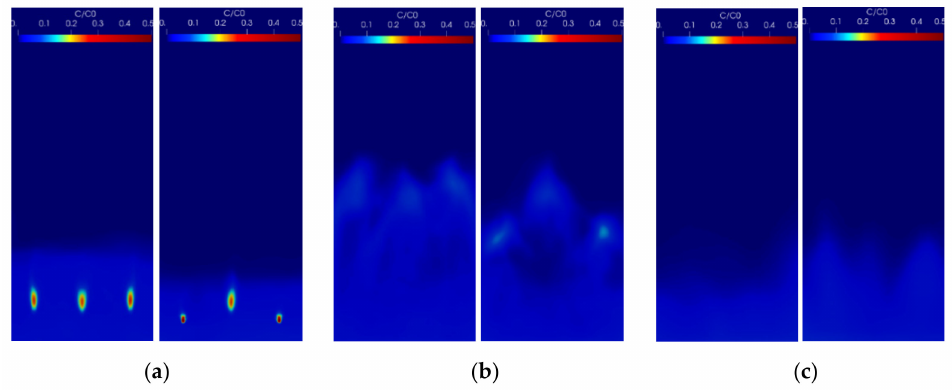
Figure 9. Concentration fields at different cross sections of uniform (case C2) and non-uniform (case S1) multiple inclined dense jets; ( a ) Section 1 (x/(D.F d ) = 0.25); ( b ) Section 2 (x/(D.F d ) = 1.5); ( c ) Section 2 (x/(D.F d ) =